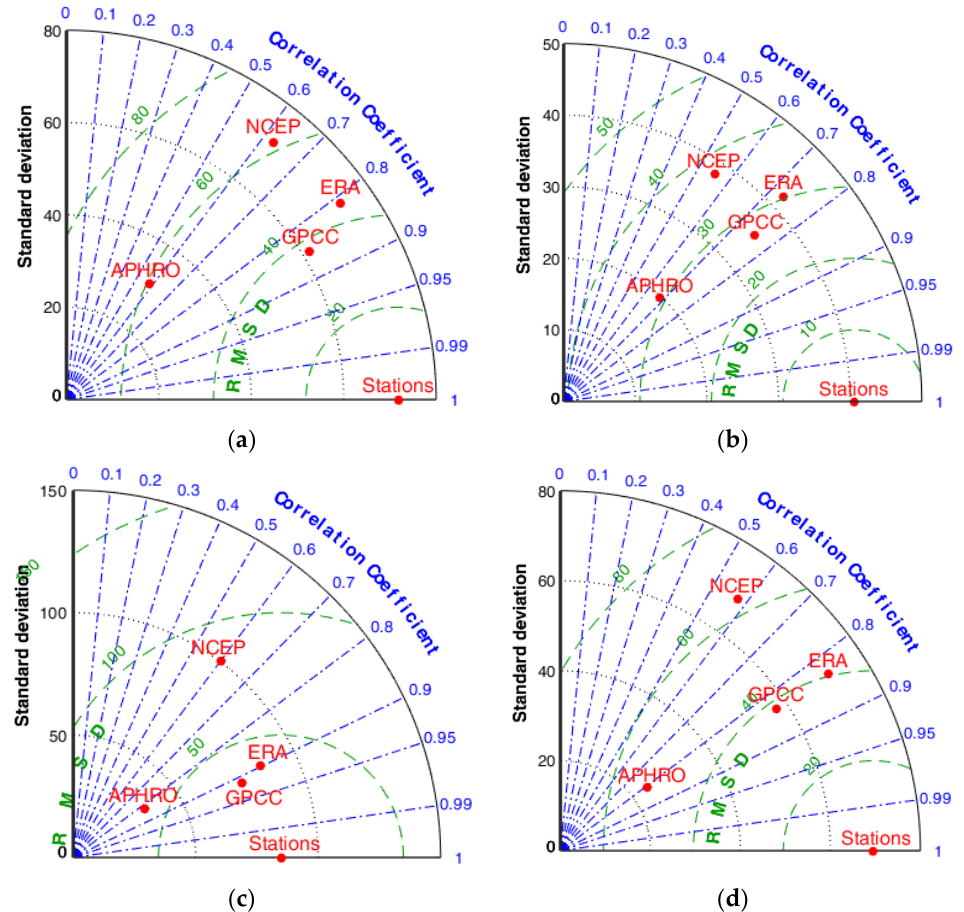
Figure 6. The comparison of the precipitation extremes (using the Taylor diagram) for the period from 1979 to 2018 (from 1979 to 2007 for the APHRO dataset) for the warm (left panel) and cold (right panel) seasons: ( a , b ) extremely low (5%) and ( c , d ) extremely high (95%). The bilinear interpolation method is used.